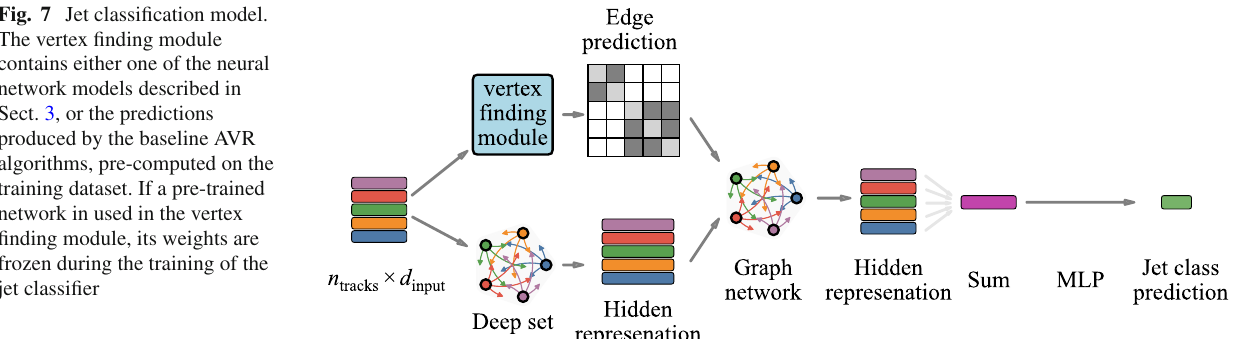
Fig. 7 Jet classification model.